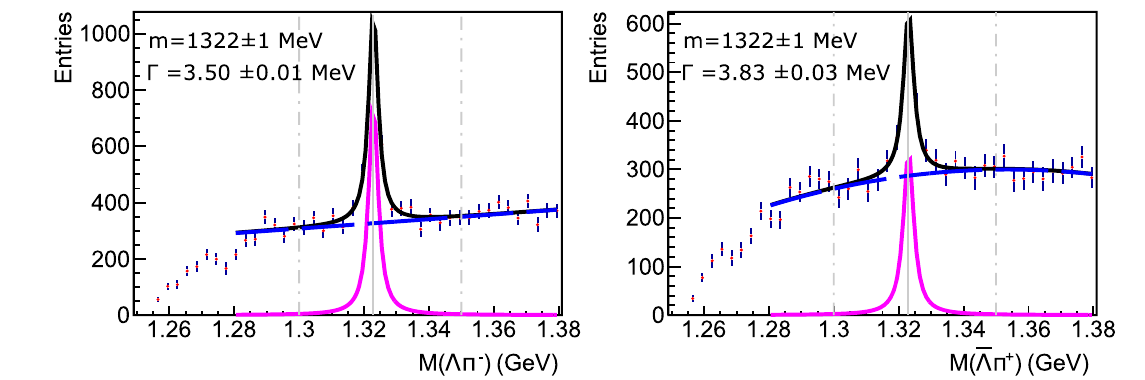
Fig. 2 Left: The (cid:3)π − invariant mass spectrum of (cid:2) − candidates for rapidity y between − 0 . 25 and 0.25 and transverse momentum p T from 0.4 to 0.6 GeV / c . Magenta line represents the fitted Lorentzian func- tion and blue one shows the fitted background, black line represents